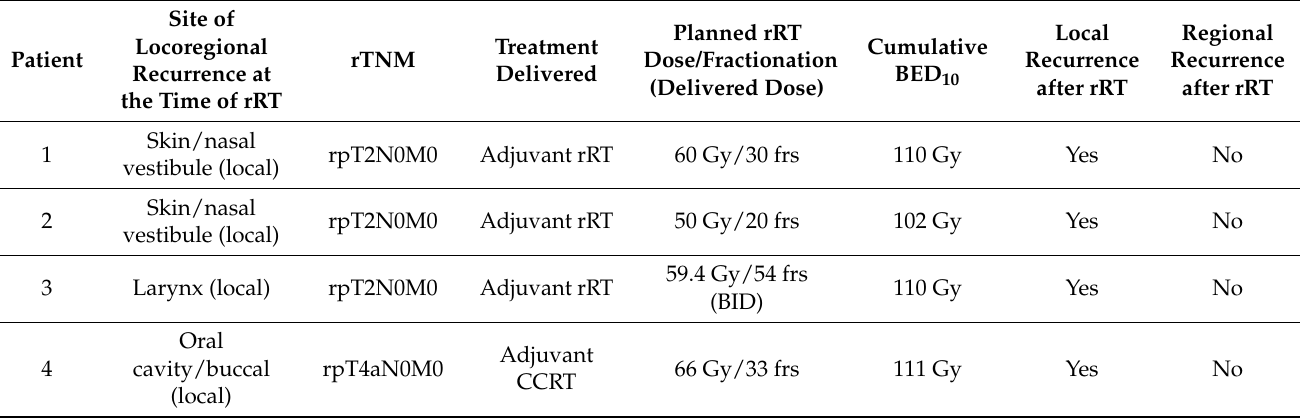
Table 2. The recurrent tumor site and stage, treatment delivered at the time of recurrence, rRT